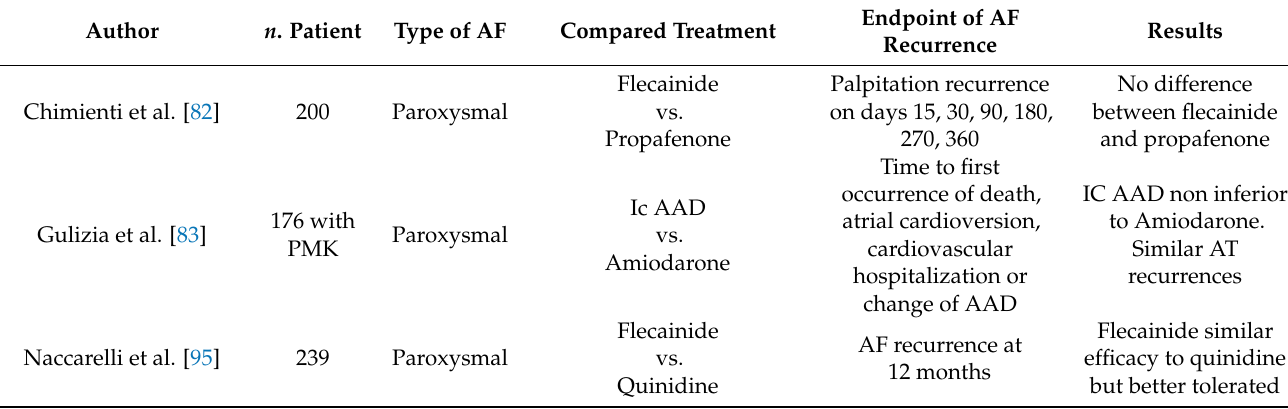
Table 4. Flecainide for maintenance of sinus